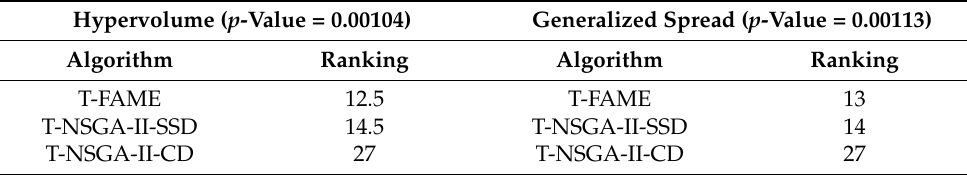
Table 15. Friedman ranks of all algorithms with hypervolume and generalized